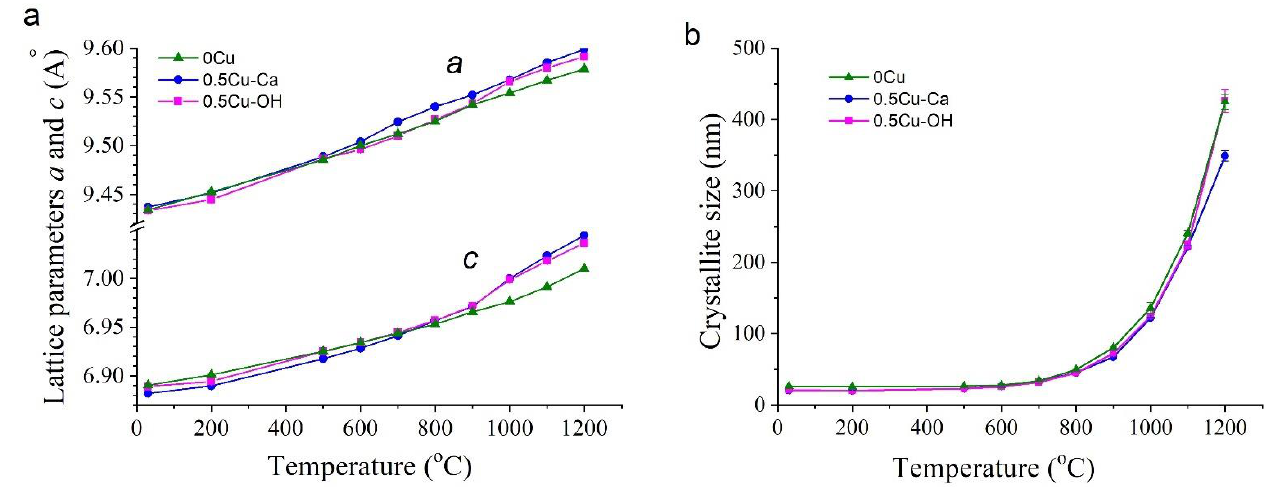
Figure 8. Shifts in lattice parameters a and c ( a ) and in the coherent scattering region ( b ) of the HA phase in the synthesized samples during heat treatment in the air atmosphere.